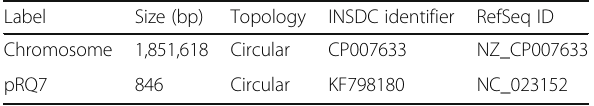
Table 3 Summary of genome: one chromosome and one